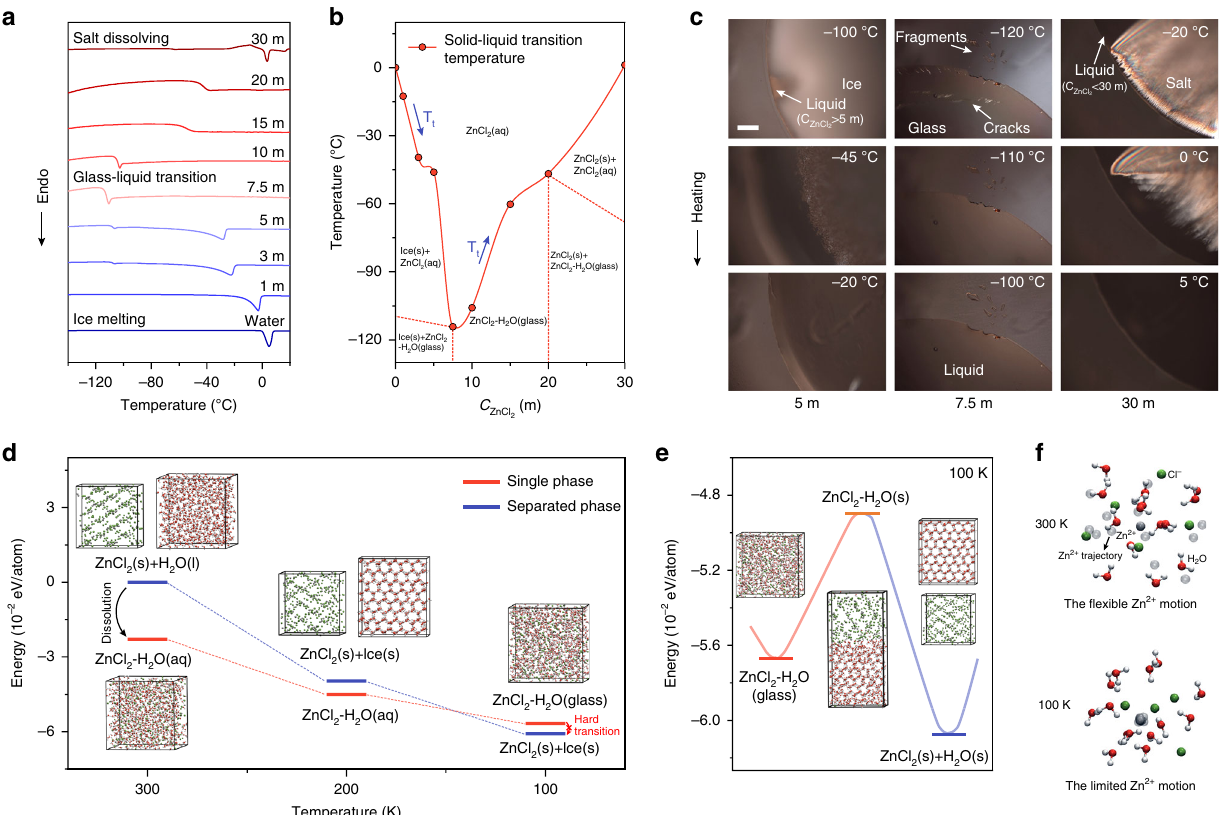
electrolyte at 2 and the phase composition of ZnCl 2 solution at different 2